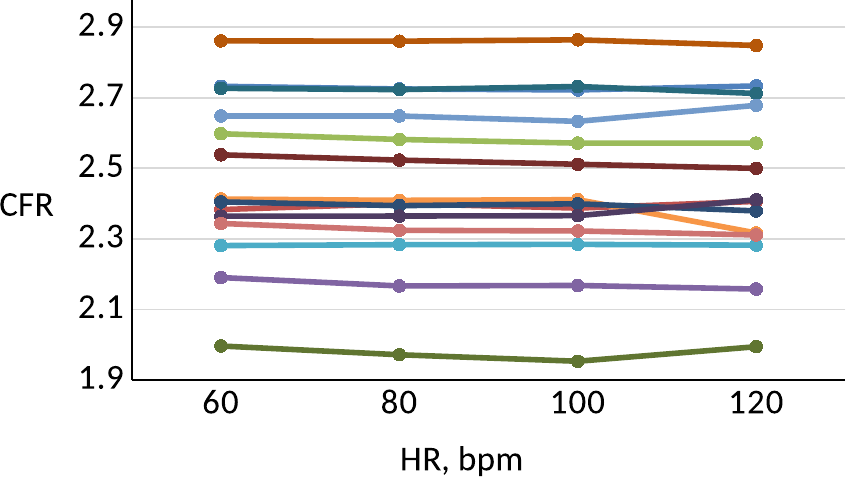
Figure 9. CFR for various heart rates, which was calculated for the full trees by the recursive